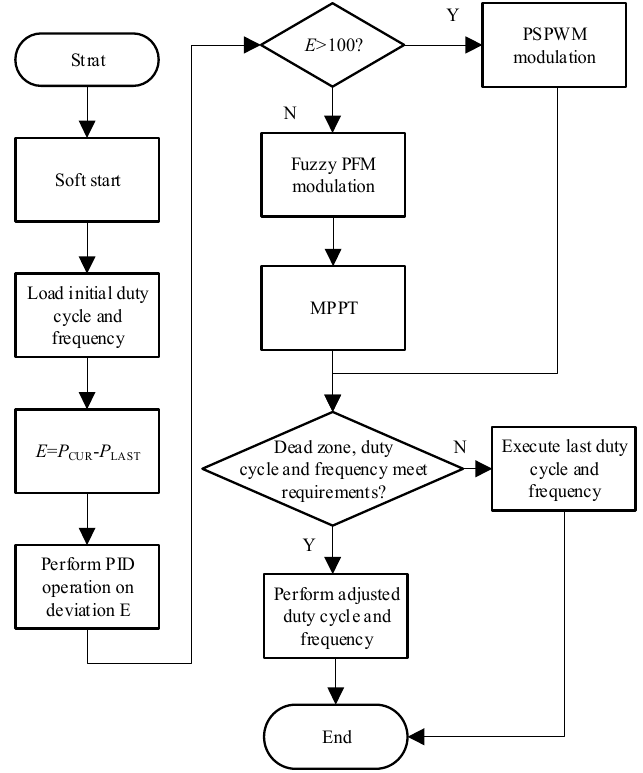
Figure 5. Flow chart of PSPWM-PFM mixed modulation control program.